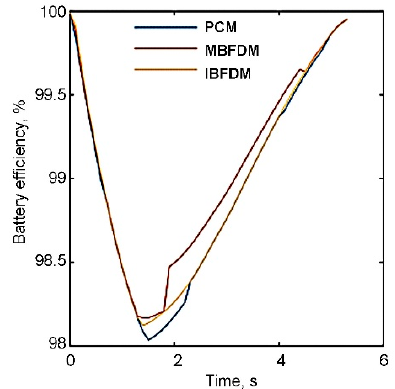
Figure 6. Change in battery efficiency.